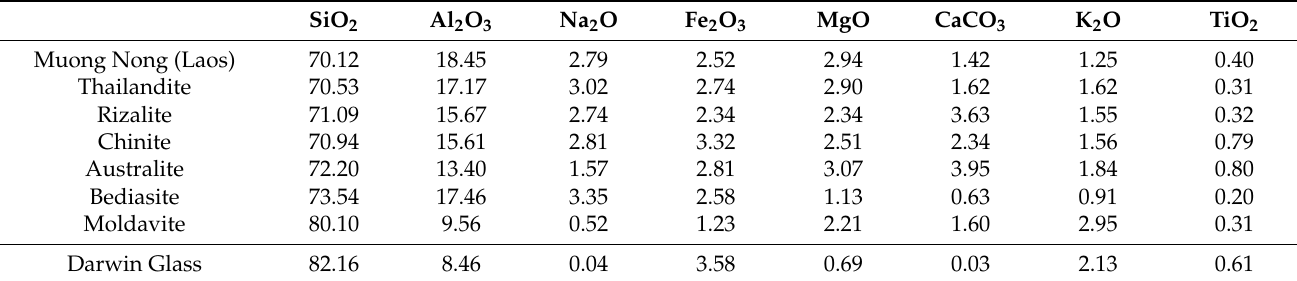
Table 6. Average major elements chemical composition (oxide wt.%) of tektites from different strewn fields and the obsidian from Arizona, determined from XRF by the first method using PANalytical instrument. The error in the values is 2%. SiO 2 Al 2 O 3 Na 2 O Fe 2 O 3 MgO CaCO 3 K 2 O TiO 2